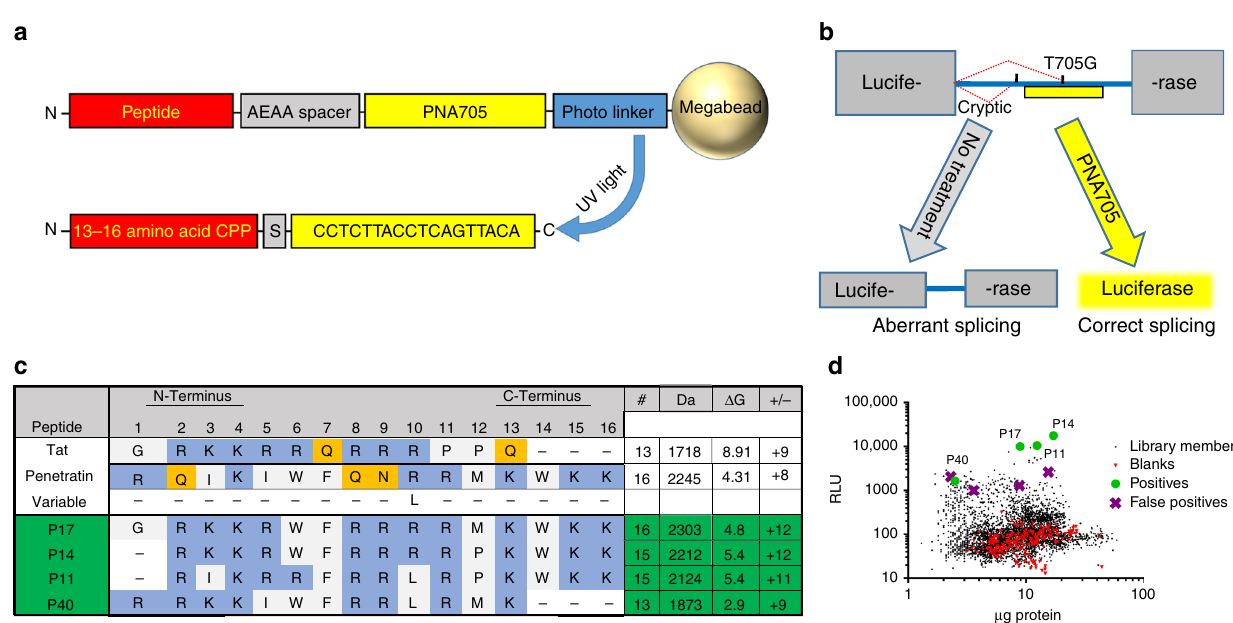
Fig. 1 Selection of positive PNA delivery peptides (PDEPs). a Strategy for solid phase synthesis of photo-cleavable PDEP – PNA705 sequences onto TentaGel-S-NH 2 megabeads. b Screening system. HeLa pTRE-Luc IVS2-705 cells possess luciferase transgenes with mutant human β -globin IVS2